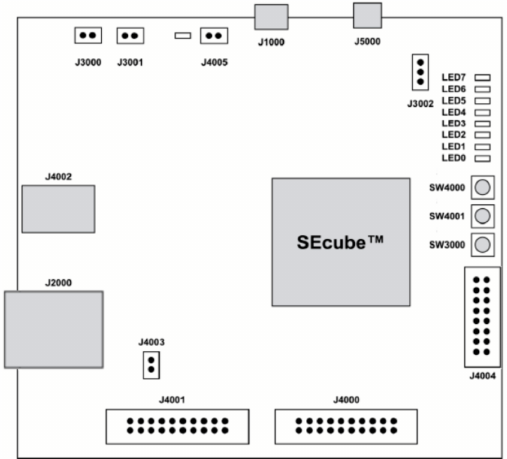
Figure 3. The main peripherals in the SEcube™